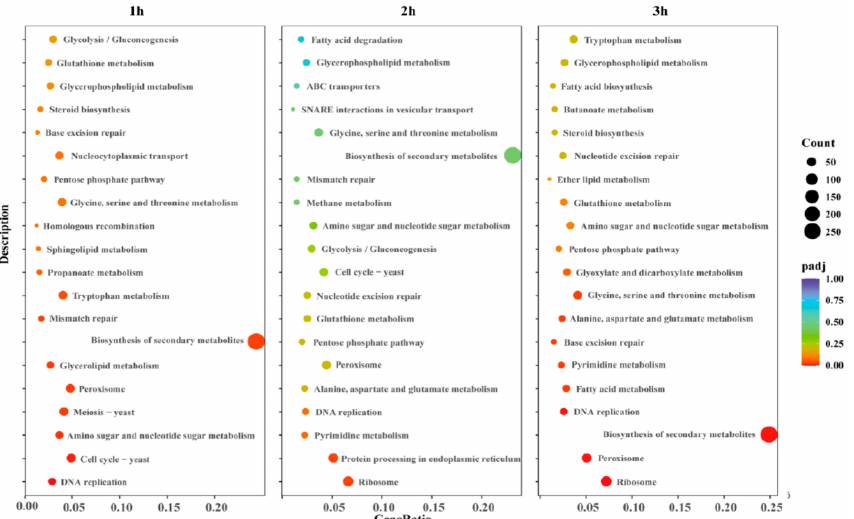
Figure 7. The pathway enrichment statistics of DEGs in N. parvum under DSEO stress after 1 h, 2 h, and 3 h of culturing. Gene ratio represents DEGs numbers to all gene numbers annotated in this pathway term. A higher value of the gene ratio means greater intensiveness; padj is a corrected p -value ranging from 0 to 1; a lesser p -value means greater